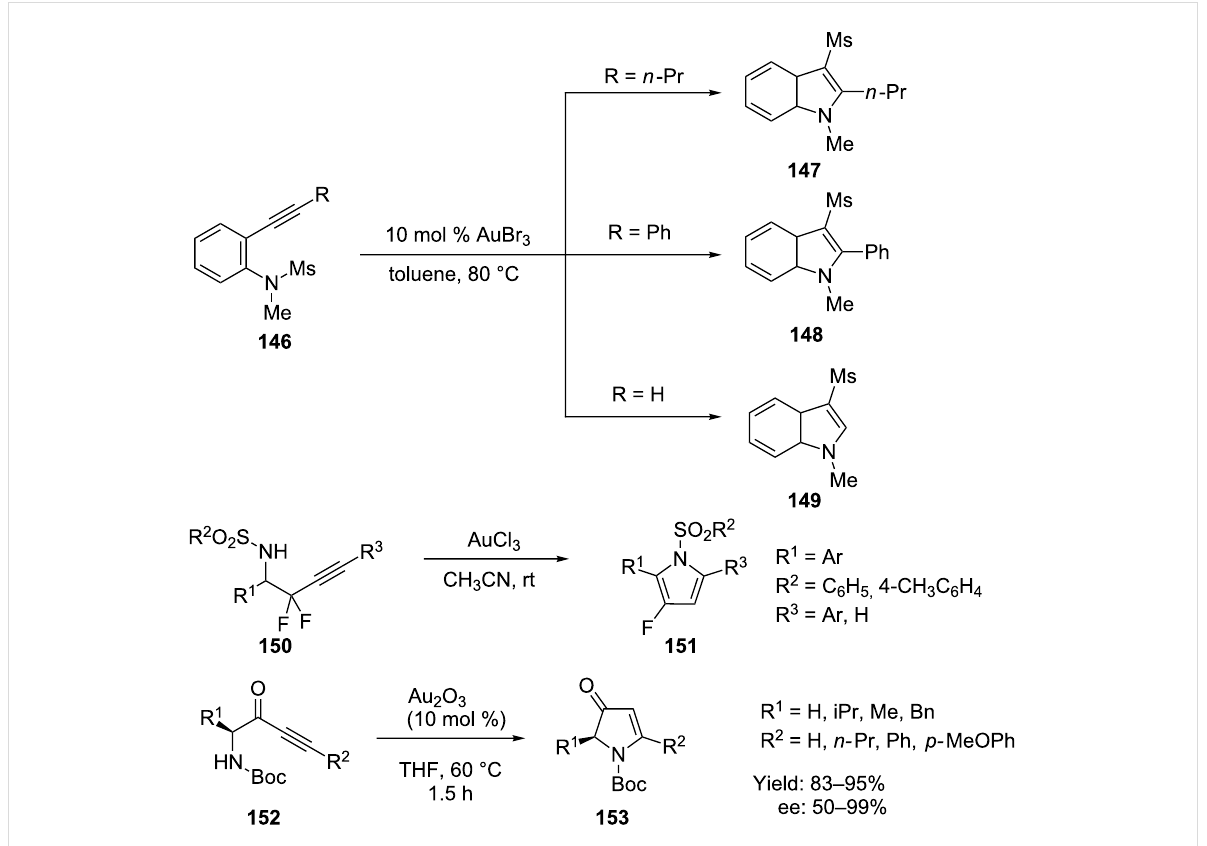
Scheme 26: Gold-catalyzed cyclization of ortho -alkynyl- N -sulfonylanilines and